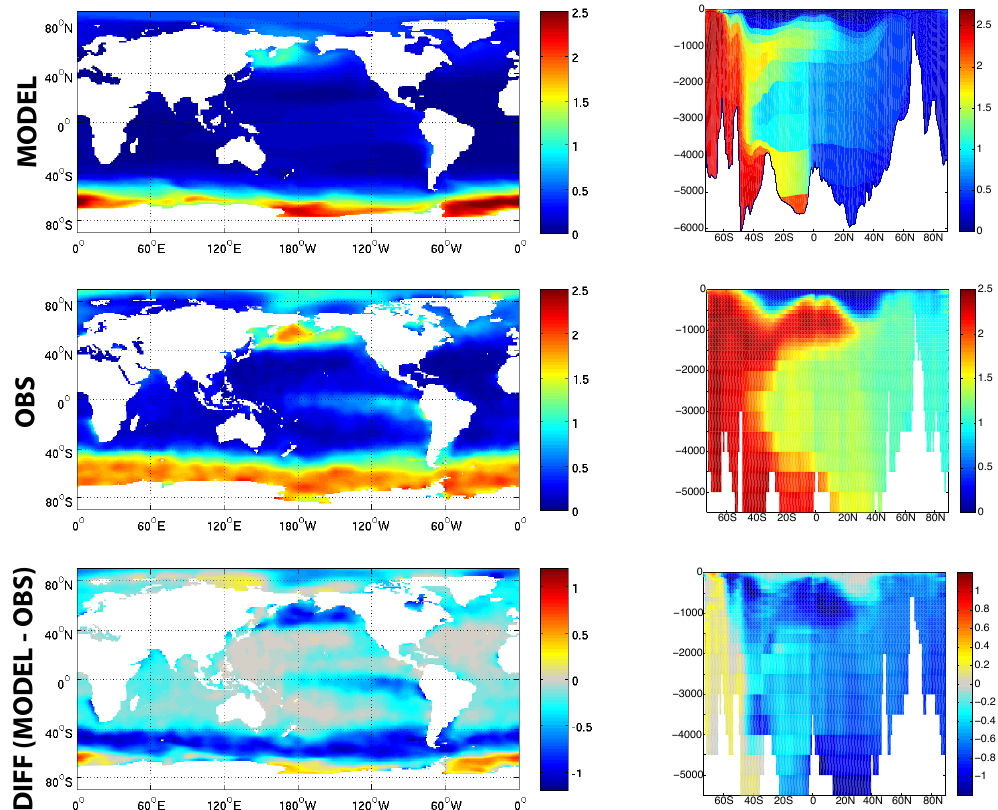
Fig. 10. As Fig. 3, but for phosphate (µmoll − 1